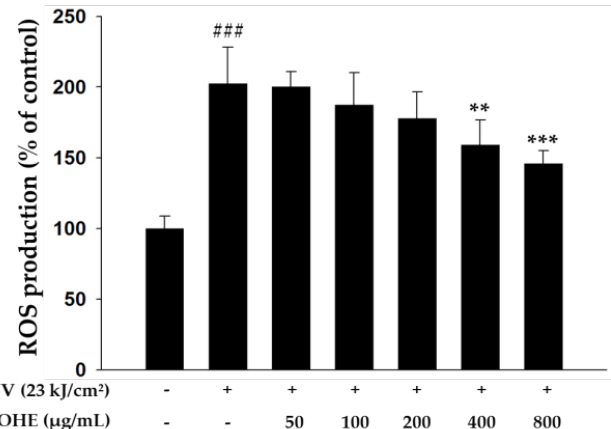
Figure 3. The inhibitory effect of Opuntia humifusa fruit water extract (OHE) on solar ultraviolet (sUV)-induced intracellular reactive oxygen species (ROS) production in human dermal fibroblasts (HDFs). Data are presented as the calculated percentage of the control group expression and shown as the mean ± standard deviation (SD). ### p < 0.001 vs. control group (Student’s t -test), ** p < 0.01, *** p < 0.001 vs. UV-radiated groups (Dunnett’s test).